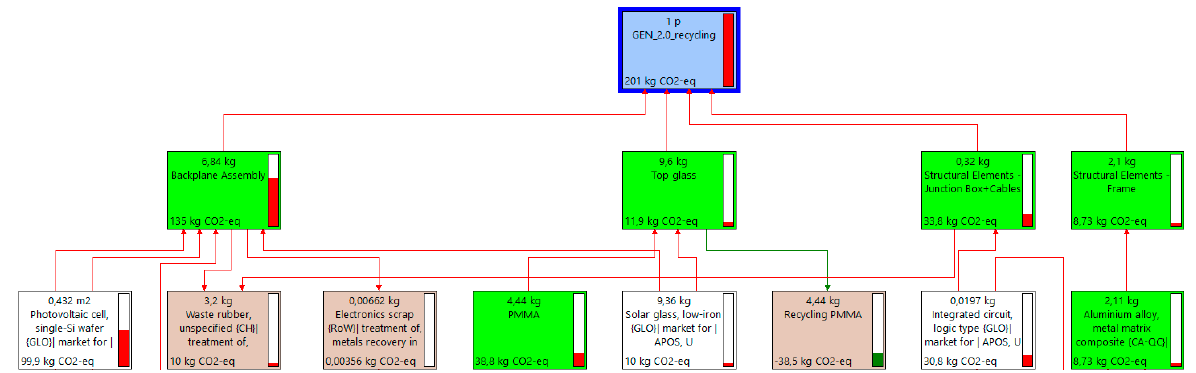
Figure 5. Reduced process tree showing the contribution of individual materials used to manufacture the module with recycling of PMMA, rubber, and electronic elements (only elements with an impact higher than 3.5% are shown).